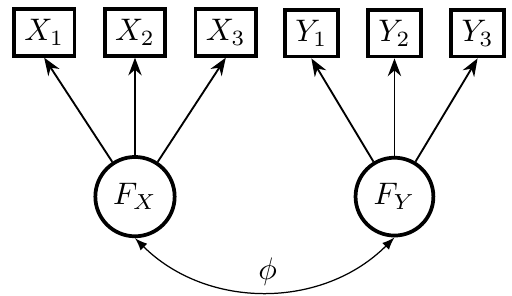
Figure 1. Two-factor CFA model: analysis model. We induce model misspecification (9) by cross loadings δ X = ( δ X ) as well as residual error correlations ψ δ Y = ( δ Y , δ Y , δ Y 2 3 1 there are no residual error correlations between items in the same measurement model (i.e., = 0 and ψ = 0 for i = j ). All residual error correlations ψ ψ X Y i Y j i X j (cid:54)